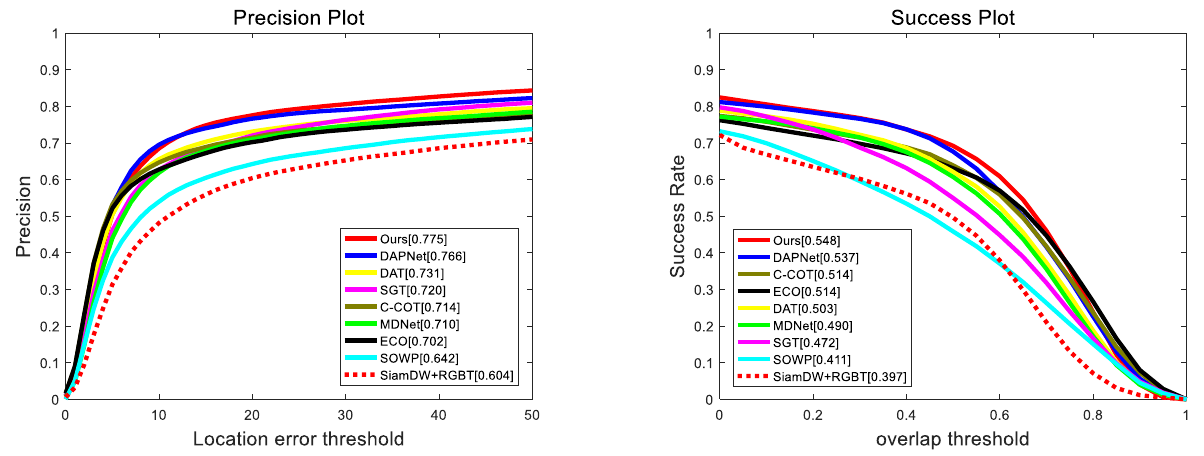
Figure 6. Precision rate (PR) and success rate (SR) curves of different tracking results on RGBT234, where the representative PR and SR scores are presented in the legend.